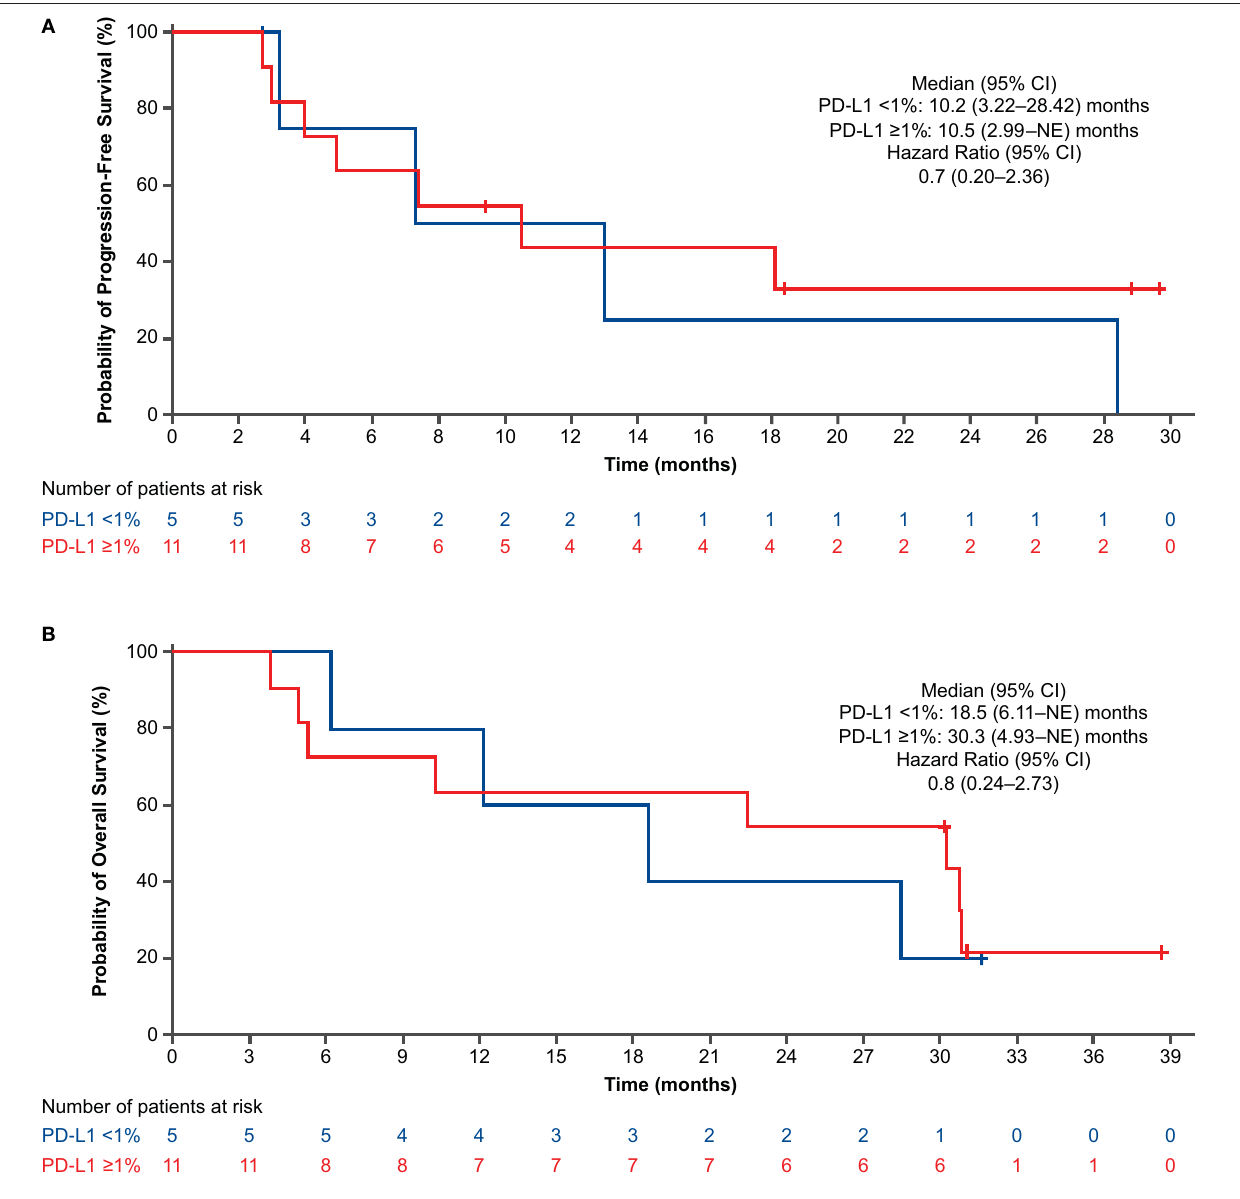
the initial RECIST-defined progressive disease, and the best percent changes in total length of target lesions from the first disease progression event in these patients were − 22, 0, 15, and